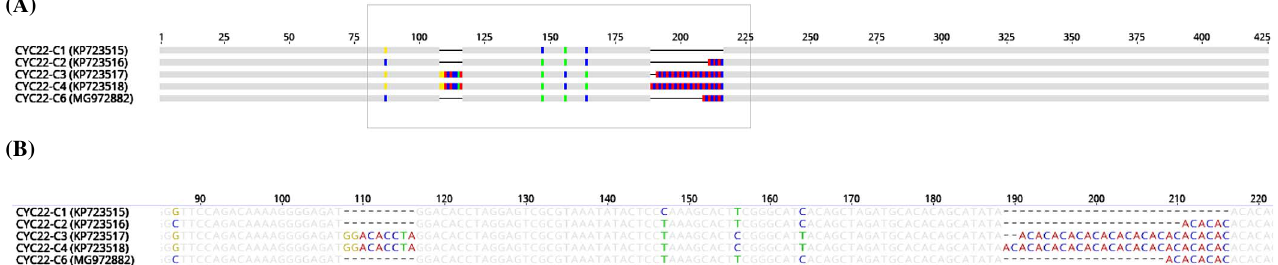
Figure 2. CYC22 sequence types. (A) Nucleotide polymorphisms among the four previously identi fi ed CYC22 sequence types [4] and a newly identi fi ed sequence type C6 (sequence type C3mixed is not shown because C3mixed and C4 had identical consensus sequences). (B) Sequence detail of the boxed area in Panel A.